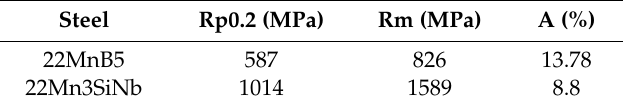
Figure 6. Engineering stress ‐ strain curves of samples before warm/hot stamping. Table 2. Mechanical properties before warm / hot